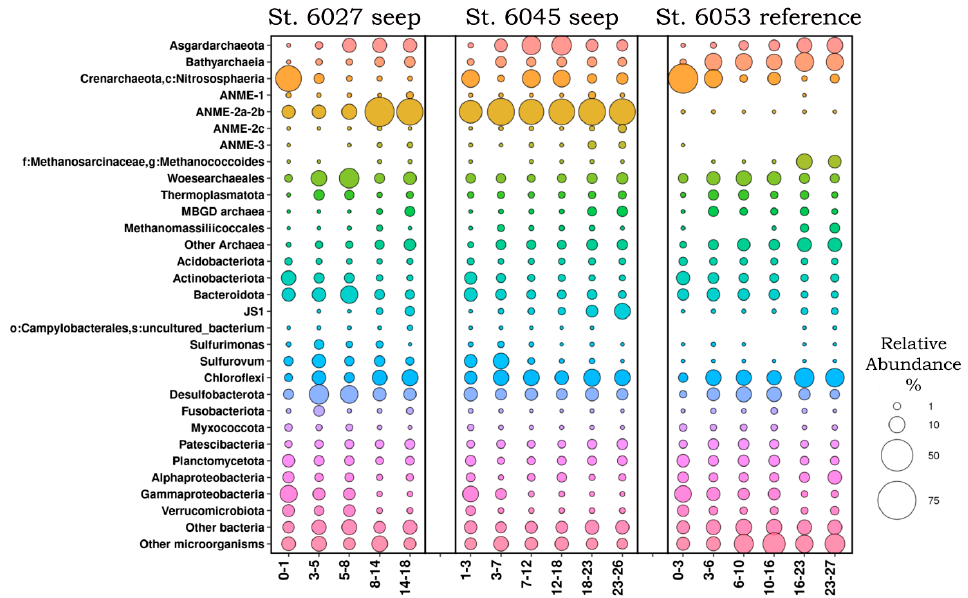
Figure 5. Microbial community composition in the surface horizons of the bottom sediments collected at three Laptev Sea stations (6027, 6045, 6053) according to the results of high-throughput sequencing of the 16S rRNA gene